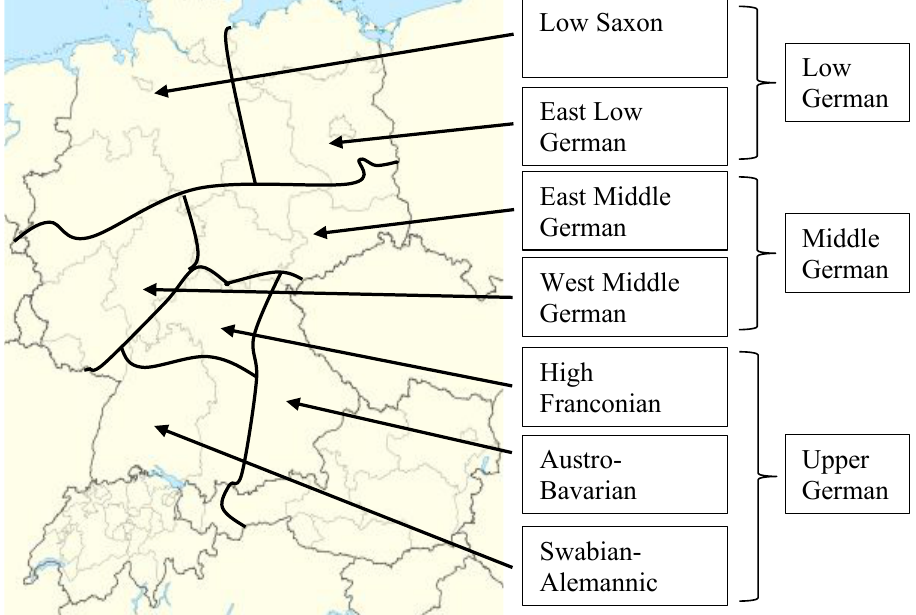
Figure 2: Main dialect divisions of German: Low German consists of Low Saxon and East Low German; Middle German is divided into West Middle German and East Middle German; and Upper German is separated into High Franconian, Swabian-Alemannic, and Austro-Bavarian (Adam 1989)